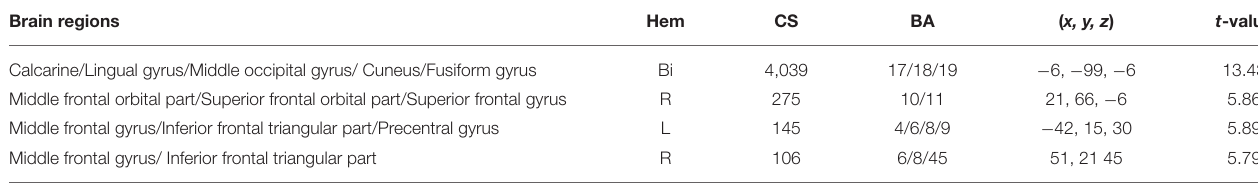
TABLE 1 | Foci of brain areas located in the neural network associated with the resting-state primary visual area- (PVA-) related spontaneous activity. Brain regions Hem CS BA ( x, y, z ) Calcarine/Lingual gyrus/Middle occipital gyrus/ Cuneus/Fusiform gyrus